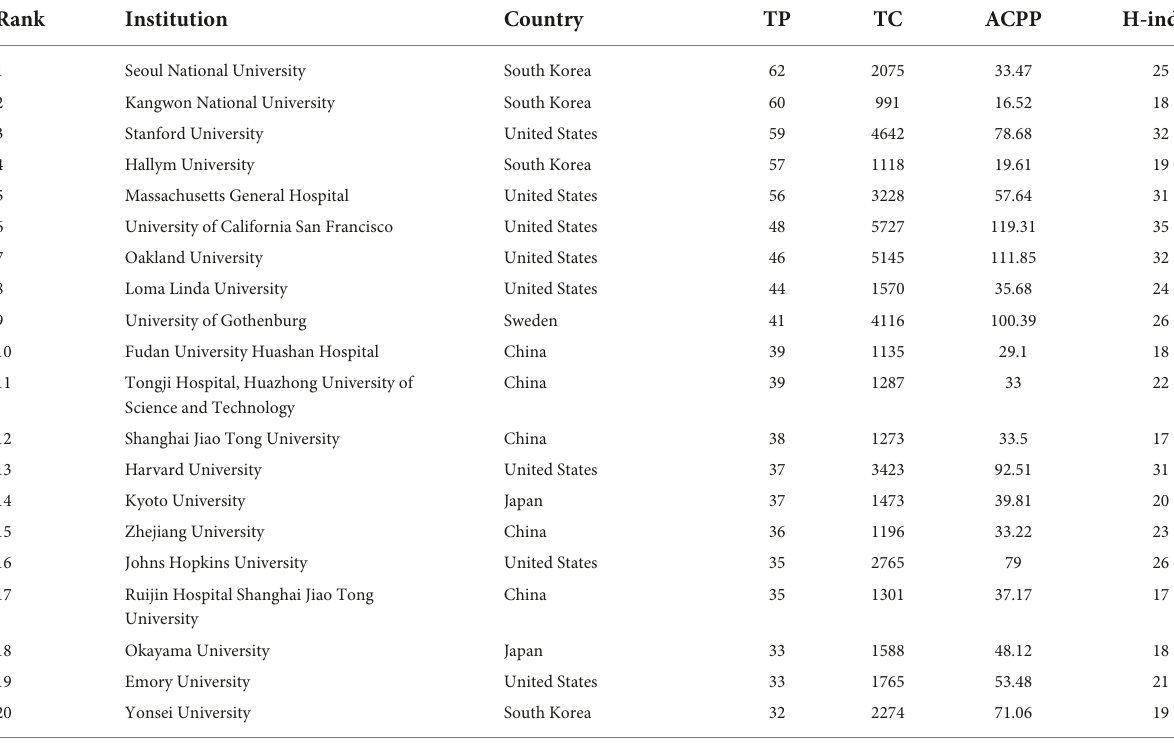
TABLE 2 Top20 most productive institutes in the field of stroke and astrocyte.